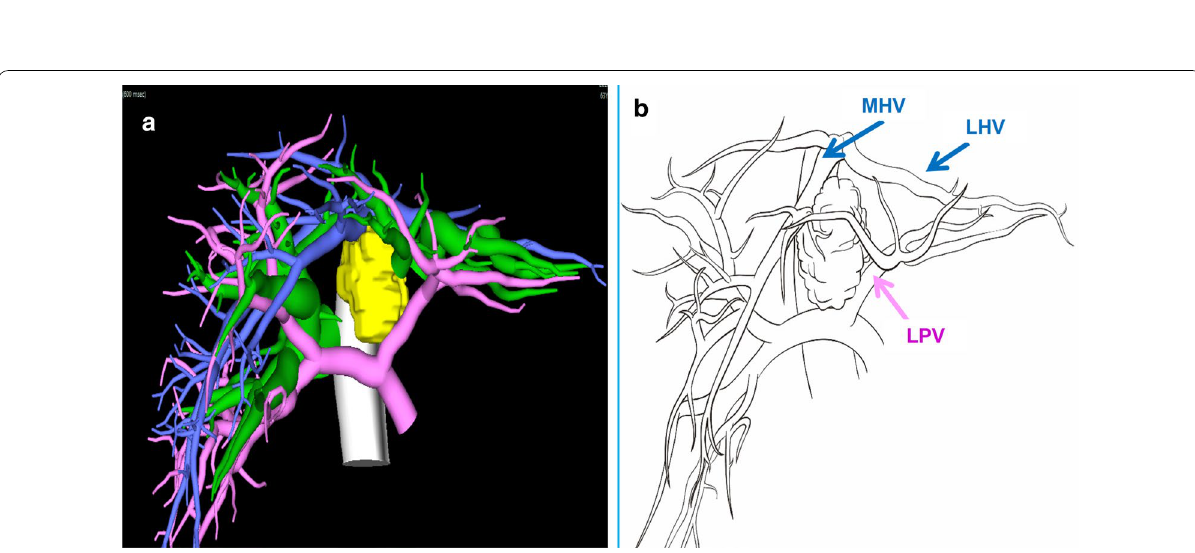
Fig. 4 Fusion images of the tumor and bile ducts: a the three-dimensional reconstruction of vessels and tumor. b Shows the relationship between tumor with portal vein and hepatic vein. The tumor infiltrated the bifurcation of portal vein and left branch, bifurcation of hilar bile duct, and the middle hepatic vein. MHV middle hepatic vein, LHV left hepatic vein, LPV left portal